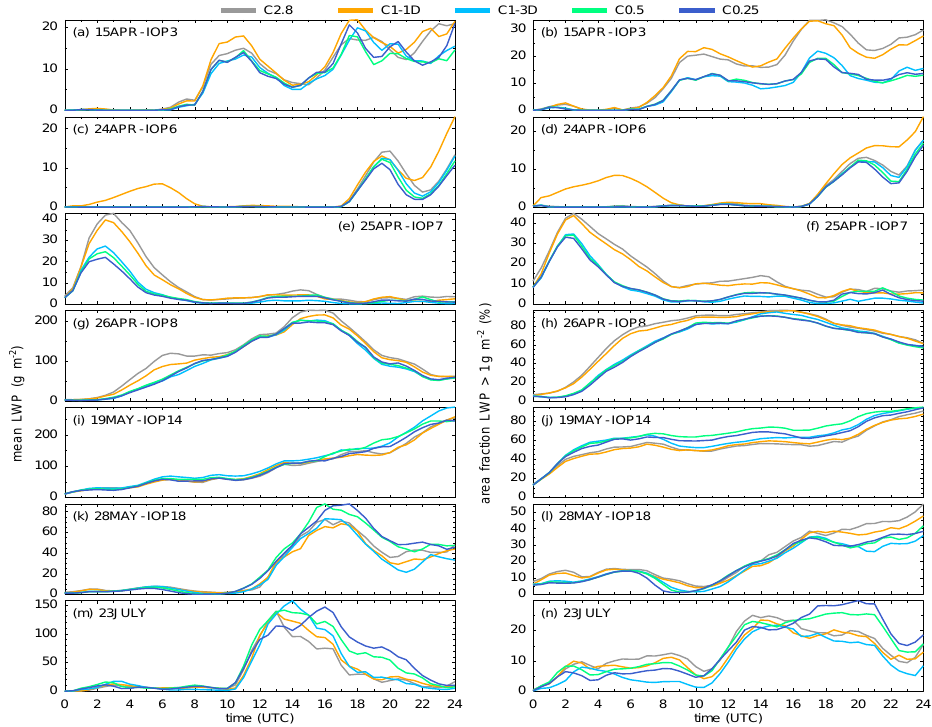
Figure 11. Domain-averaged liquid water path (left column) and fraction of grid points with liquid water path values exceeding 1gm − 2 (right column) in the common investigation